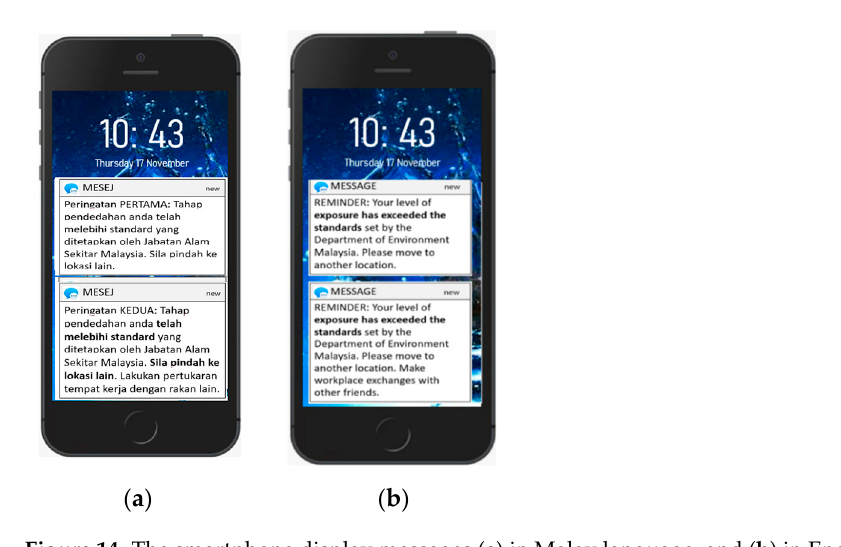
Figure 13. Daily average of PM 2.5 mass concentration for the prototype and the DustTrak.